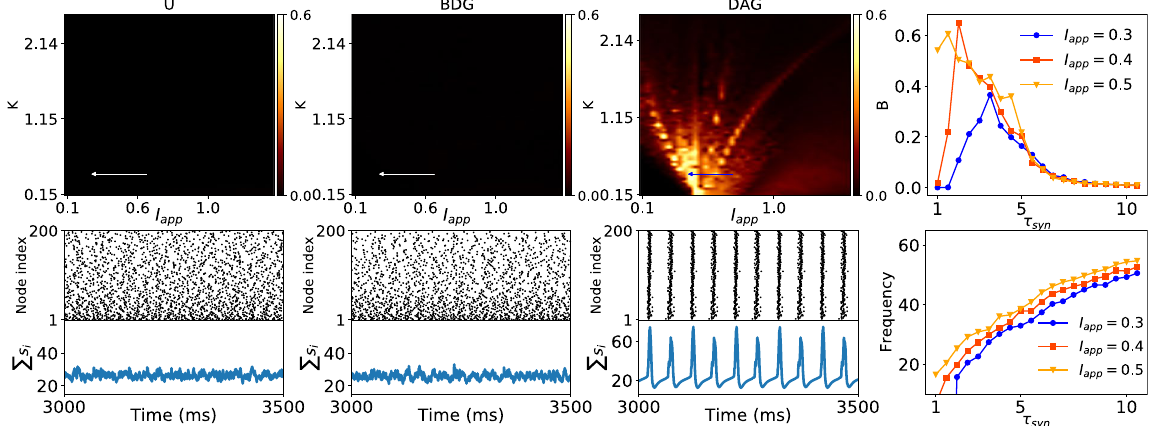
Figure 7. Synchronization of Traub neurons coupled via scale-free undirected and oriented graphs. (First three columns) Top panels show the spike synchrony of the networks on − I K the raster plots and the sum of the synaptic gates ∑ s by the arrows at the top plots. The synapse parameters are α β = = . = . − − g 12 ms , 0 5 ms , 0 01 mS/cm (Right column) Top and bottom panels represent the effects of synaptic time constant ( τ β = 1/ synchrony and frequency of oscillation, respectively at = . K 0 3 . The parameters of the network are valued as = N 200 , and γ = 3